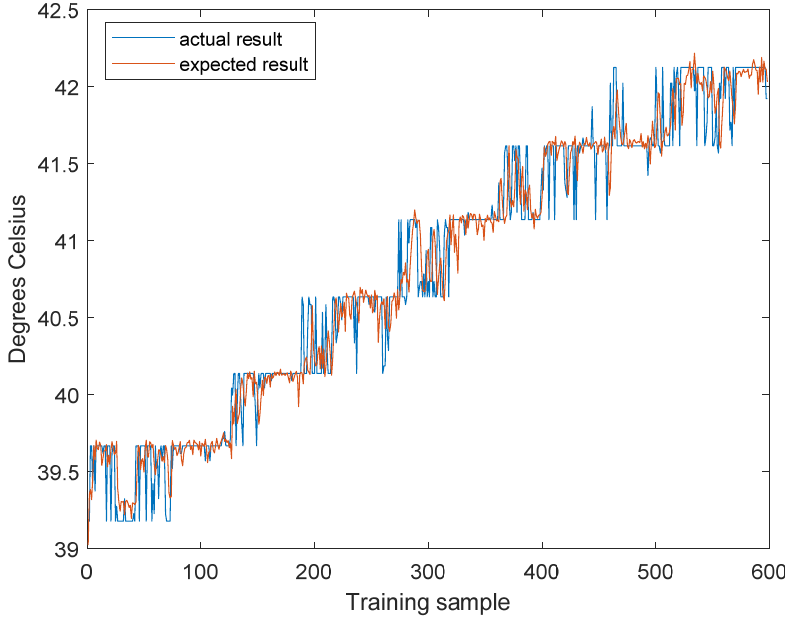
Figure 9. Prediction result.